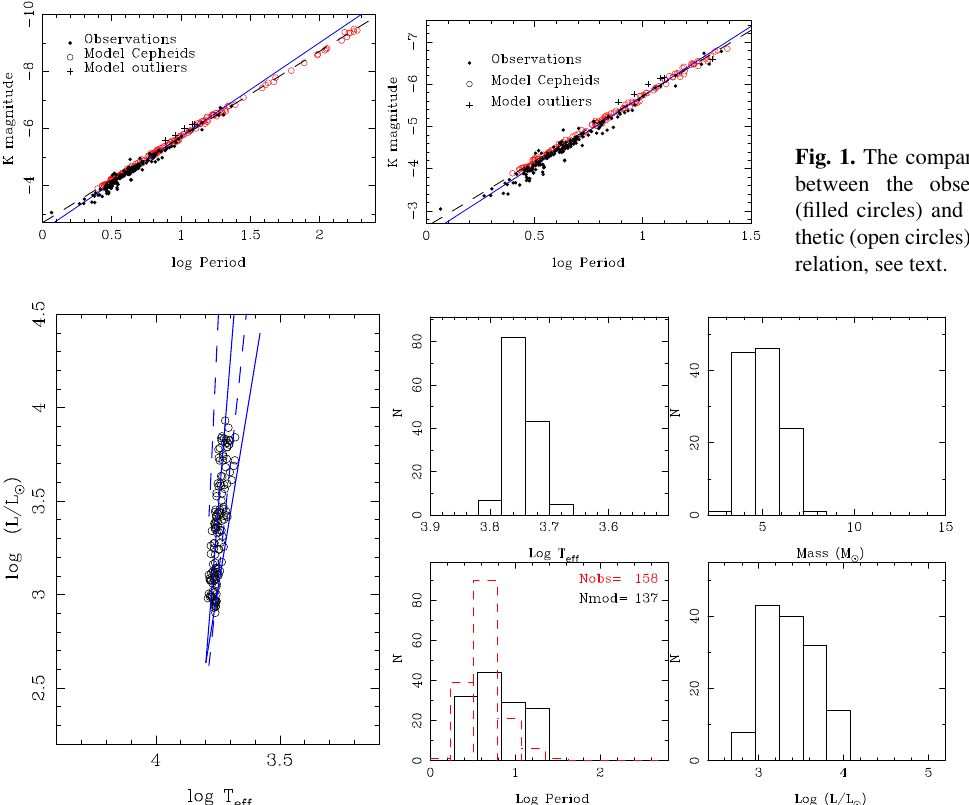
Fig. 2. The synthetic HRD on the left, with the instability strip for Z = 0 . 02 (solid line) and Z = 0 . 004 (dashed line) indicated. On the right synthetic histograms of e ff ective temperature, mass, period, and